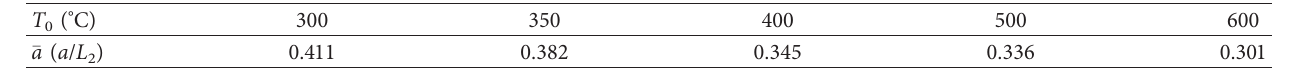
Figure 18: Thermal crack numbers with different initial temperatures ( t � 1.0s). Table 5: Average crack lengths with different initial temperatures ( t �